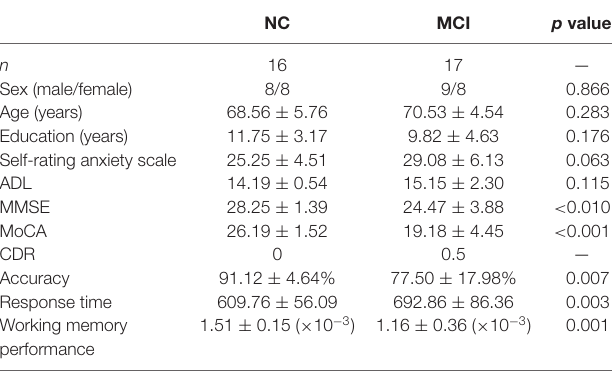
TABLE 1 | Summary of participant demographic